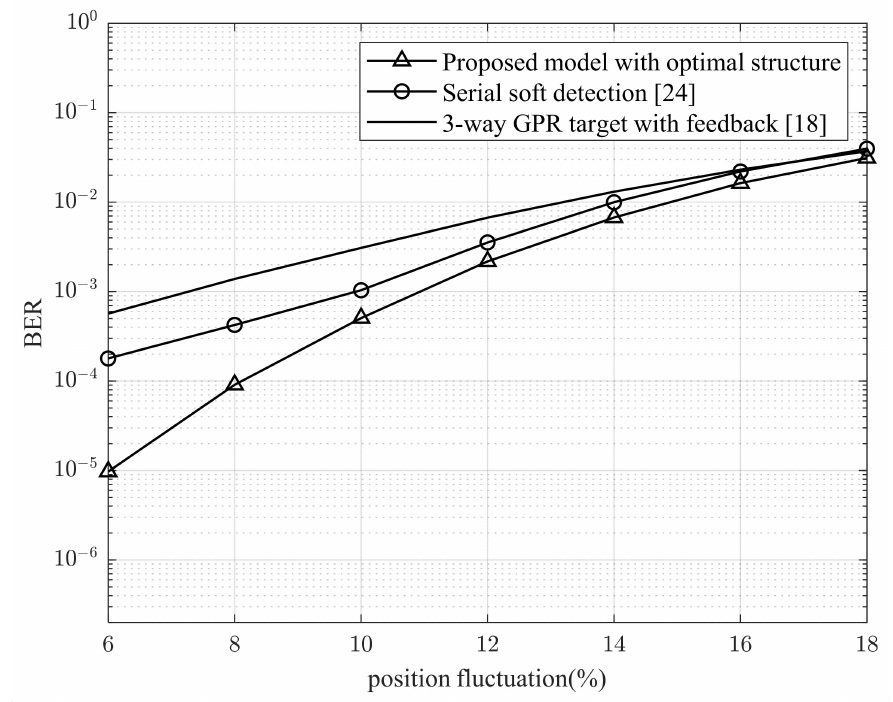
Figure 8. BER performance of the proposed model according to position fluctuation at SNR = 15 dB